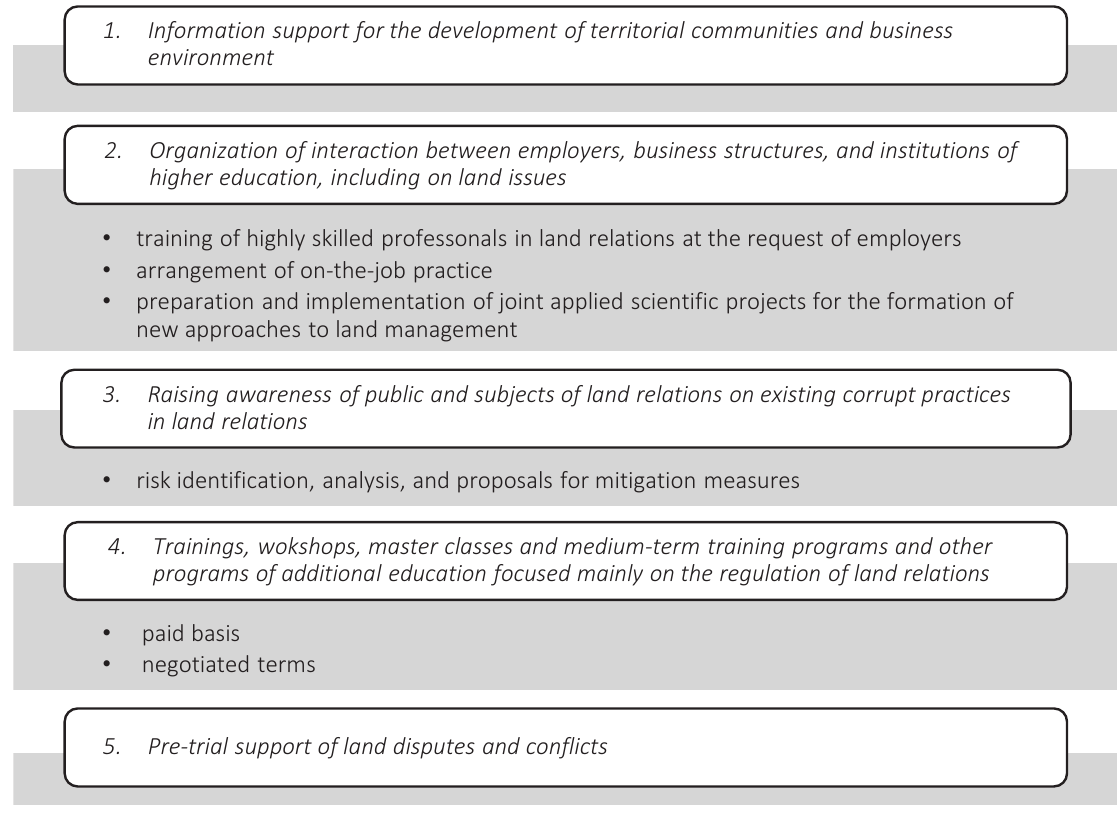
Figure 1. Possible activity directions of scientific and consulting center for legal assistance to the territorial communities’ development in the context of land reform accomplishment in